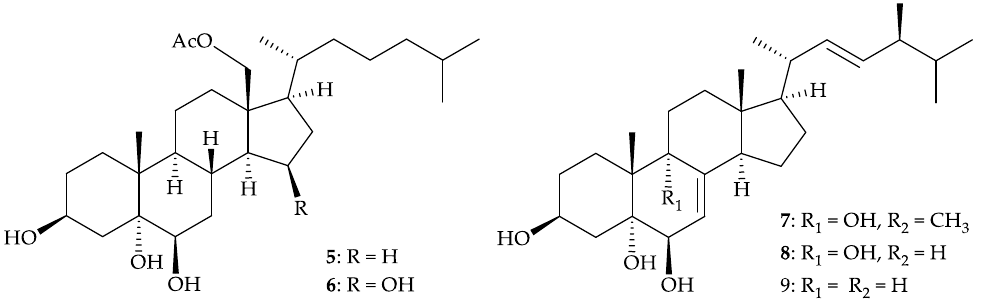
Figure 2. Structures of dendronesterols A ( 5 ) and B ( 6 ), (22 E ,24 S )-24-methyl-cholesta-7,22-diene-3β, 5α,6β,9α-tetrol ( 7 ), (22 E )-cholesta-7,22-diene-3β,5α,6β,9α-tetrol ( 8 ), and (22 E )-24-norcholesta-7,22- diene-3β,5α,6β-triol ( 9 ).